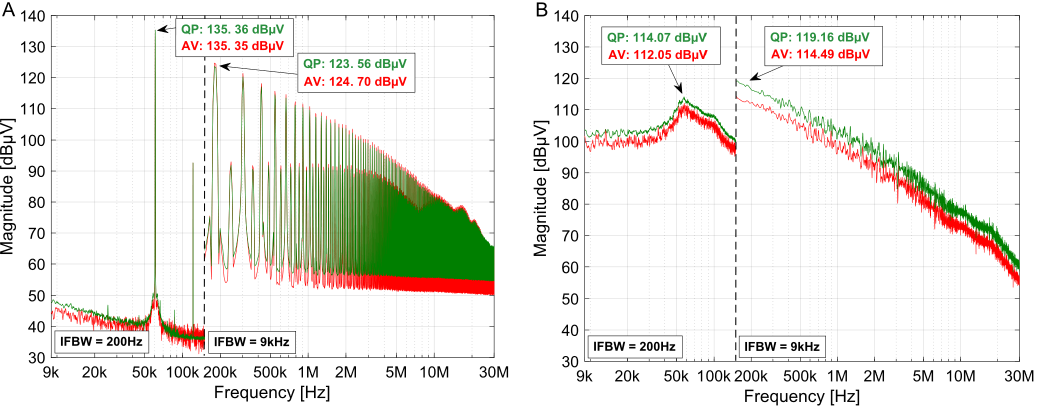
Figure 1. Electromagnetic interference (EMI) measurement of DC/DC converter with the fsw = 60 kHz and d = 0.5: ( A ) for deterministic modulation (DetM) and ( B ) for random modulation (RanM). Results obtained through the FPGA-based system proposed in